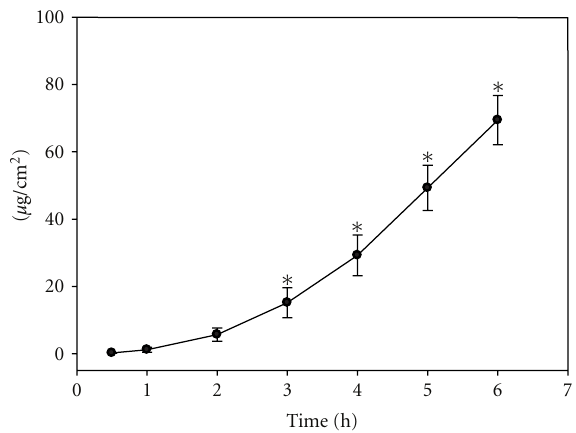
Figure 4: The penetration of ibuprofen. The curve displays mean values ± SD. The values are given in μ g/cm 2 . ∗ P < 0 . 05 versus 30min values.